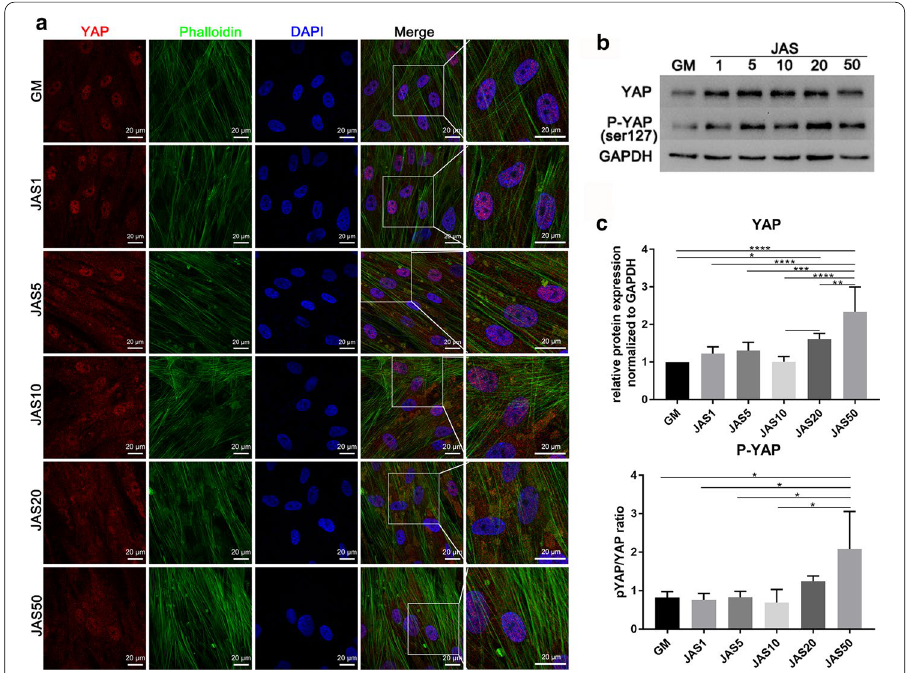
Fig. 5 Actin polymerization can promote localization of YAP protein to the cytoplasm. a Cells were cultured in medium containing different concentrations of JAS. Then, cells were fixed and immunofluorescence stained with anti-YAP antibodies. Fluorescence for YAP and actin is shown in red and green, respectively. Nuclear staining is represented in blue. All images were obtained using a 63 oil immersion lens on the × confocal microscope; b Western blot analysis for YAP and p-YAP (Ser127) of hASCs cultured in medium containing different concentrations of JAS. Scale bar 20 =